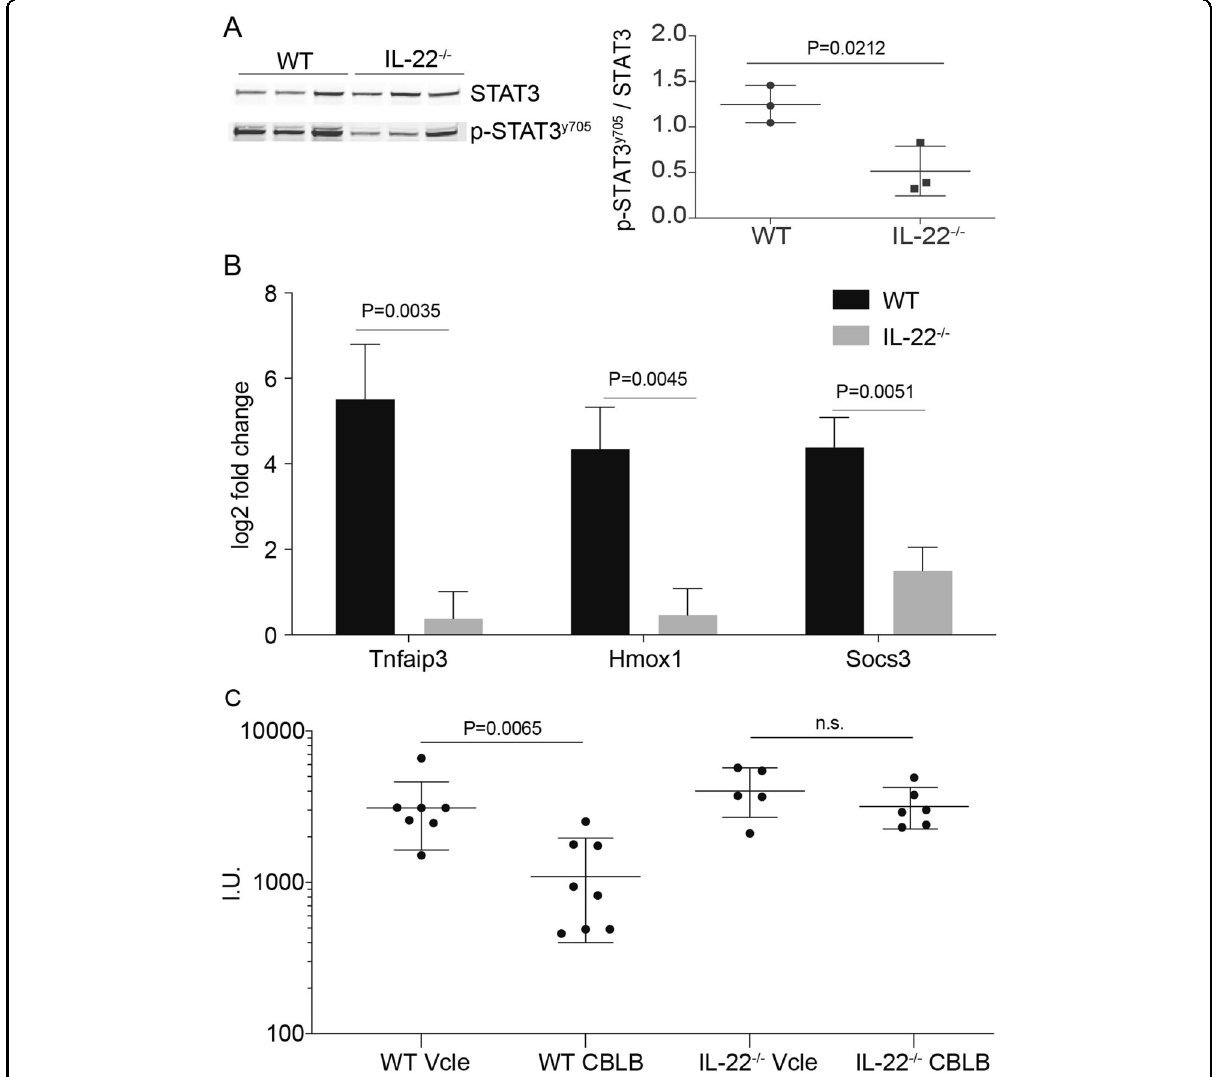
for total STAT3 and STAT3 phosphorylated at tyrosine 705, 2 h following CBLB injection and the corresponding STAT3 phosphorylated at tyrosine 705/STAT3 ratio, n = 3 mice per group. B qPCR of three of the cytoprotective genes (Tnfaip3, Hmox1, and Socs3) in WT and IL-22 − / − mice 2 h following CBLB injection, n = 3 mice per group. C Serum ALAT levels 6 h after